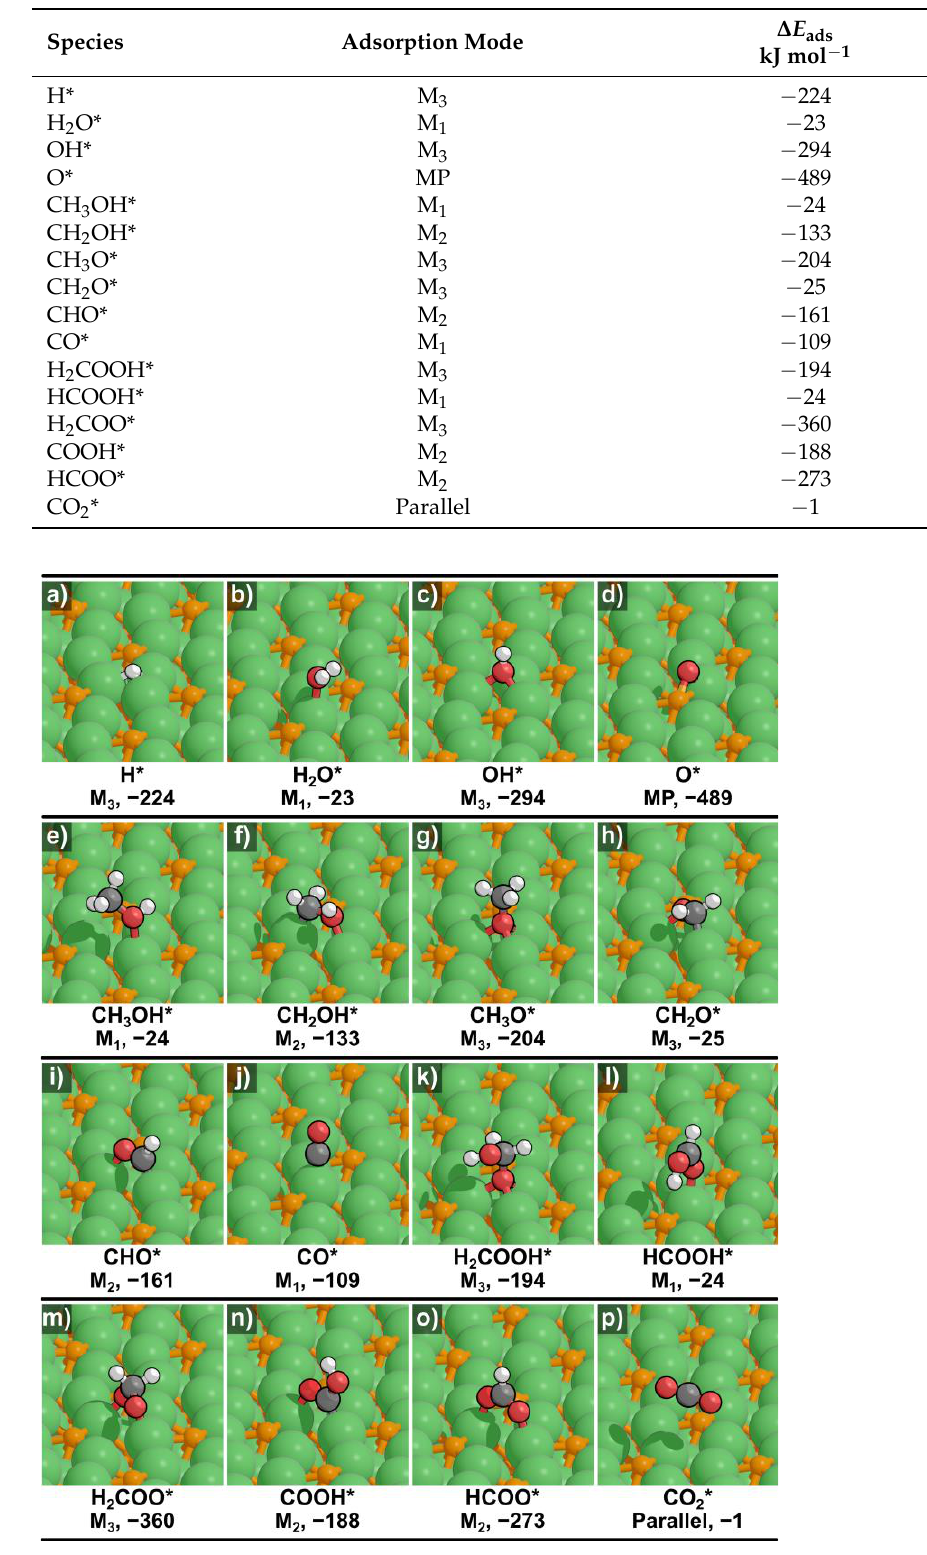
Figure 1. ( a – p ) The most stable adsorption geometries for all MSR intermediates examined in this study. Shown beneath each image are the adsorption mode (see Section 3 for more details) and the binding energy calculated using Equation (4) in kJ mol − 1